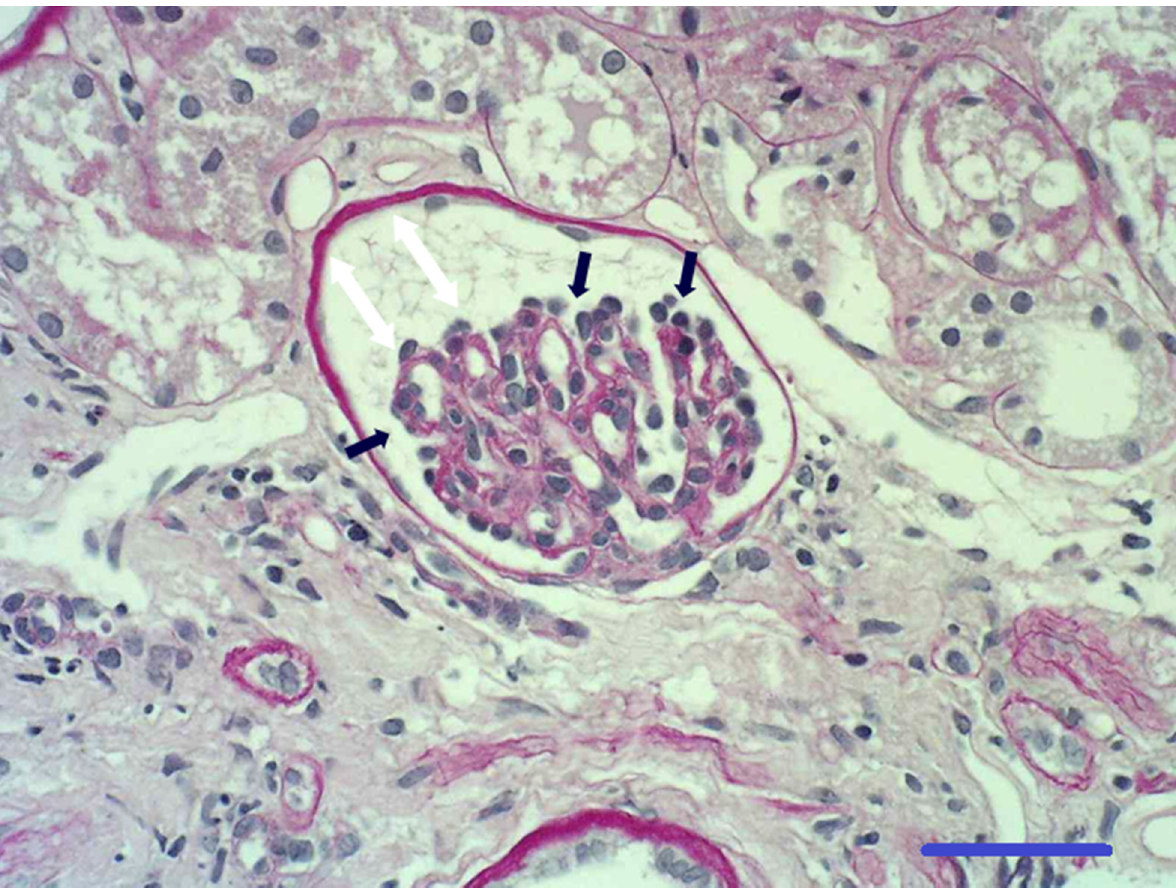
Figure 1. Photomicrograph of glomerulus from a section of a renal biopsy specimen. The glomerular capillary tuft is small and incompletely developed (it contains only a few small capillaries with open lumens). There is prominence of the visceral epithelial cells located on the outer contours of the glomerular capillaries (black arrows). The glomerular capillary tuft does not fill its Bowman’s capsule (white arrows), which is small without being enlarged. The Bowman’s capsule is of normal thickness and has a few parietal epithelial cells lining its inner surface. Periglomerular fibrosis is absent. Periodic acid–Schiff stain 400×: bar 50 µm.